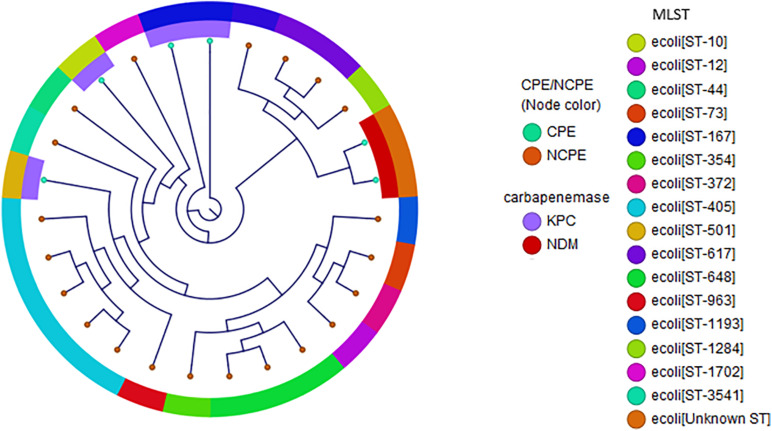
Phylogenetic reconstruction of E. coli. Distribution of isolates using SNP-based core genome alignments. Node color indicates CPE or NCPE. Layer 1 shows carbapenemase types. Layer 2 shows clonal groups by MLST.